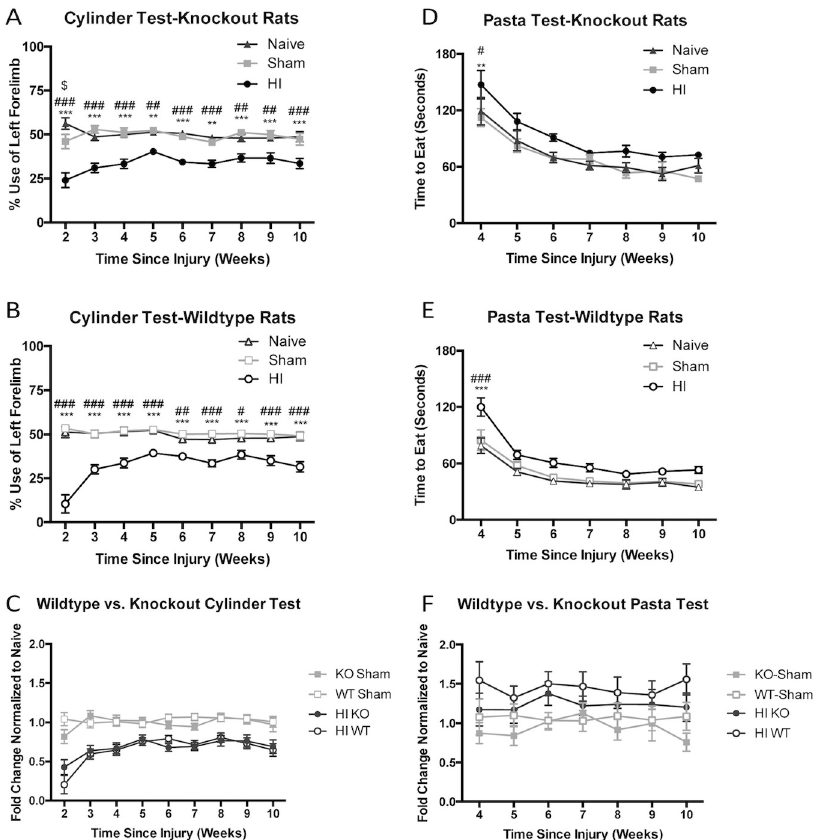
Fig 2. Behavioural outcomes. Both Prkdc KO (A) and WT (B) injured animals are impaired in the use of their left forelimb when compared to Na ï ve and surgical Sham animals. There is no difference in performance of injured animals on the cylinder test when compared across genotypes (C). Both KO (D) and WT (E) HI animals take significantly longer to complete the pasta test at 4 weeks after injury, but perform similarly to uninjured animals after this time-point. There is no difference in performance of injured animals on the pasta test when compared across genotypes (F). Error bars = ± SEM. # p < 0.05, ## p < 0.01, ### p < 0.001 Na ï ve vs. HI; �� p < 0.01, ��� p < 0.001 Sham vs.